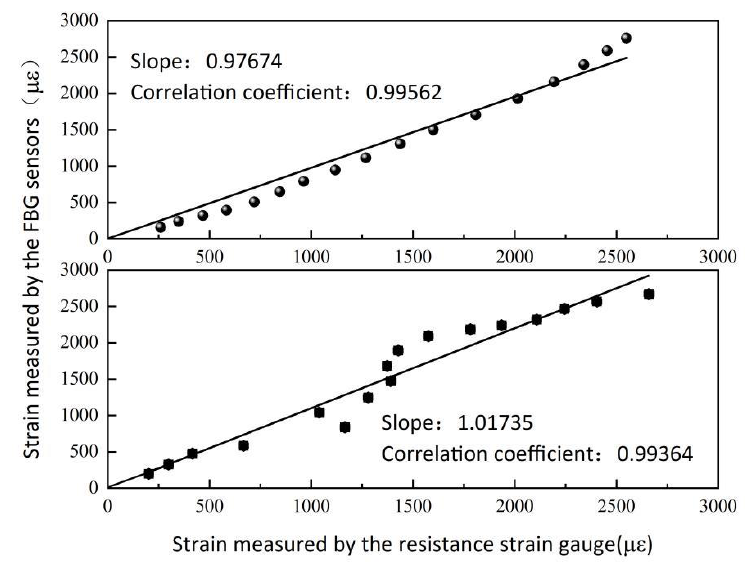
Figure 11. Corresponding relationship of the strain measured by the resistance strain gauge sensors and FBG sensors.